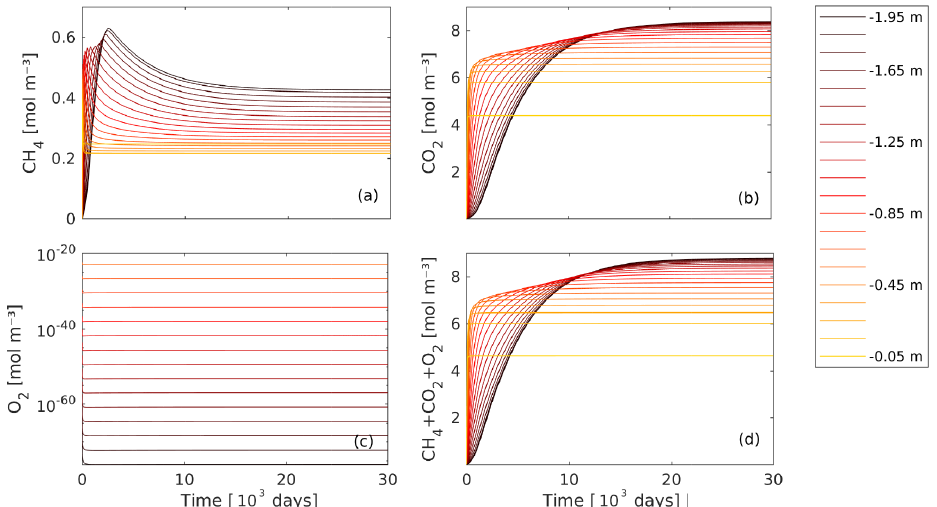
Figure 3. Evolution of the concentration profiles of (a) CH 4 , (b) CO 2 , (c) O 2 , and (d) their sum in a simulation where both WTD and LAI were zero; i.e., there was no plant transport of these compounds. Different colors show the concentrations at different depths in the peat. In the beginning of the simulation, all the concentrations were